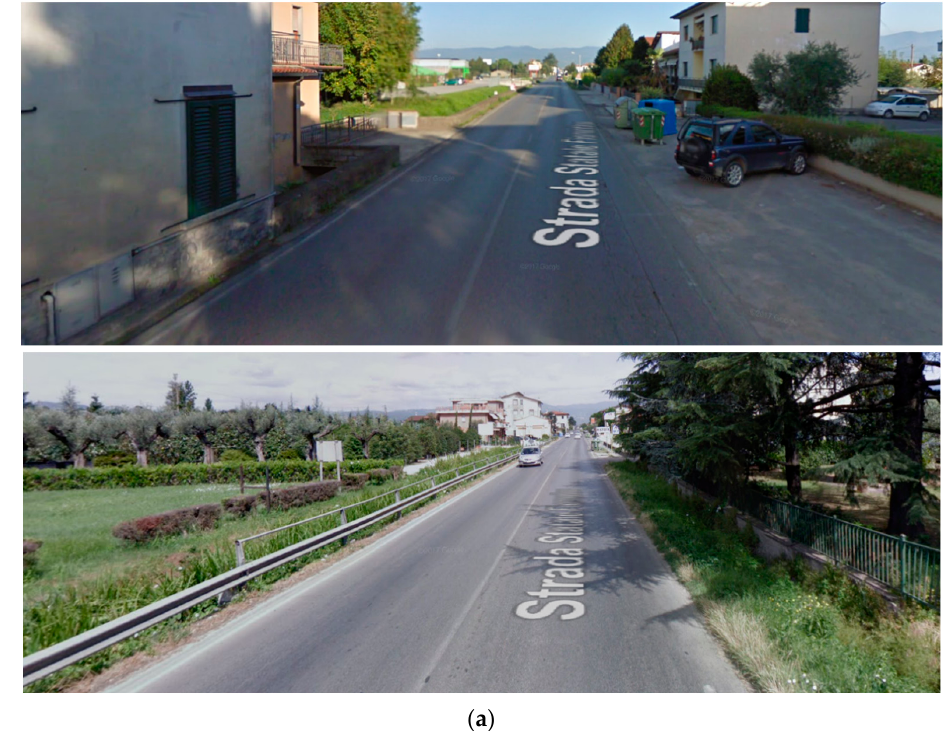
Figure A10. Cont